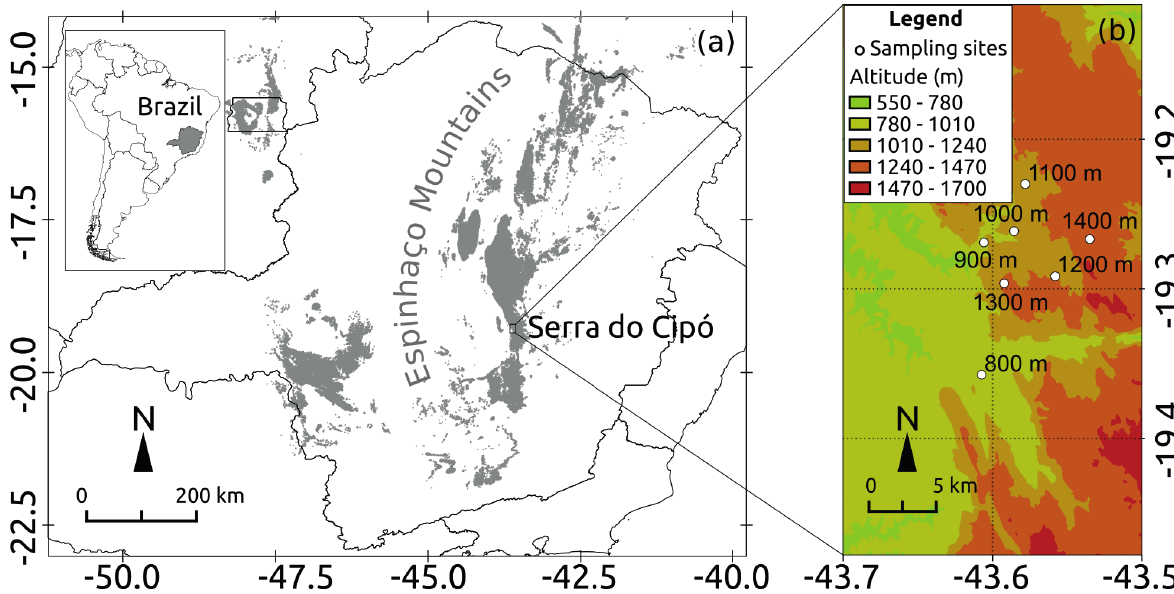
Figure 1. Map of the study sites along an altitudinal gradient in Serra do Cipó, Minas Gerais, Brazil. (a) Location of rupestrian grasslands along the Espinhaço Mountains (gray area) in Minas Gerais State, Brazil. (b) Sampling sites (white circles = weather stations) at each